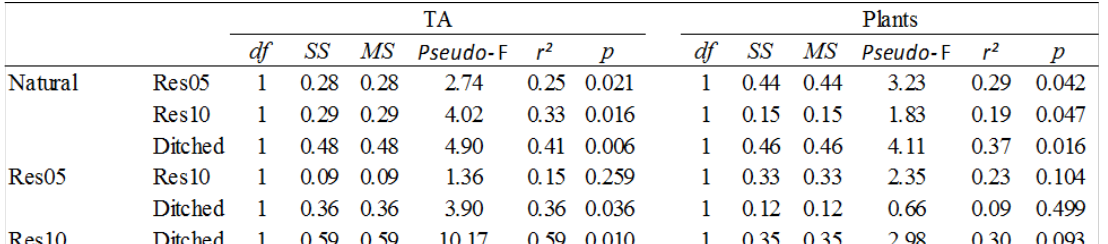
Table 2. PerMANOVA pairwise comparisons for TA and plant community structure and composition.